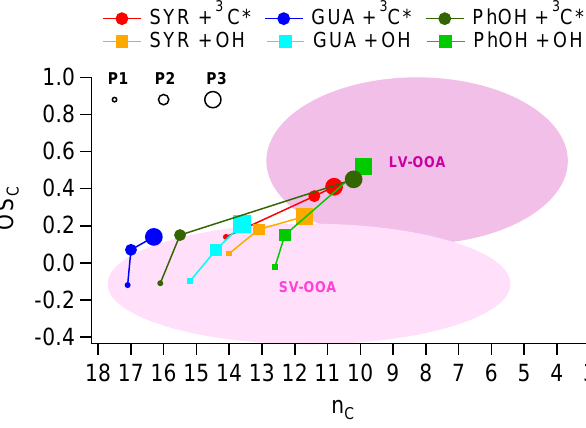
Figure 4. Average OS C and n C of phenolic aqSOA formed during different stages of 3 C ∗ - and • OH-mediated reactions. The OS C val- ues were determined based on the AMS data and the nC based on (–) nano-DESI MS data. The different phenolic and oxidant condi- tions are represented by the symbols shown in the legend. The sym- bol sizes increase with irradiation time. The shaded ovals indicate regions of LV-OOA and SV-OOA reported in Kroll et al.